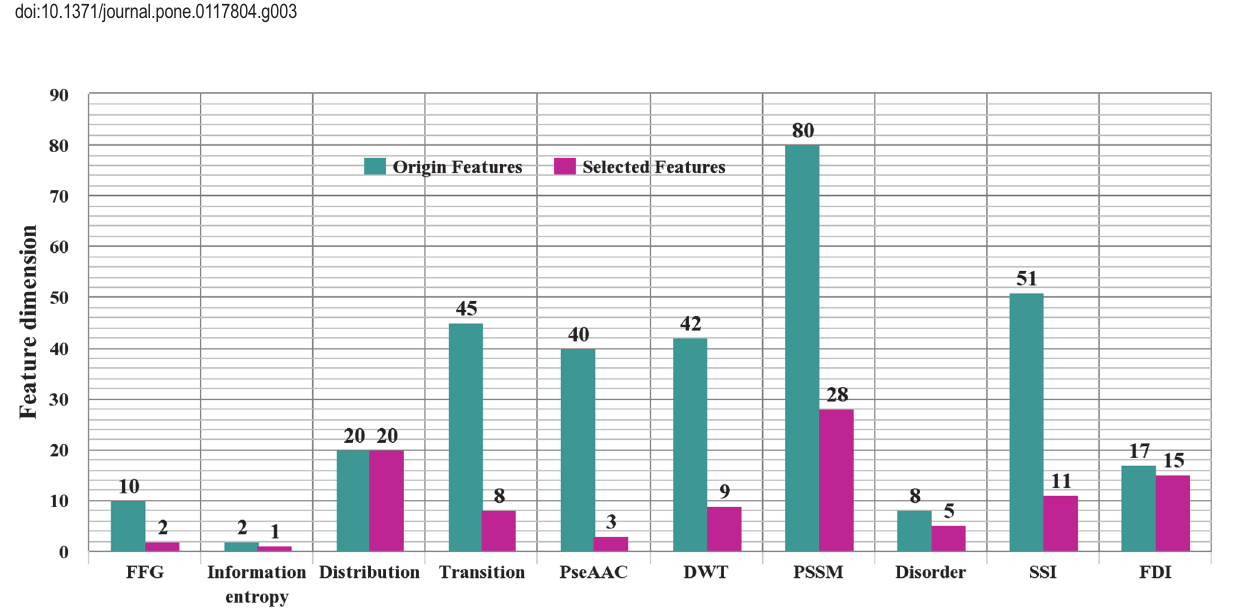
Fig 4. The feature type distributions in the original and optimal feature set. FFG: Frequencies of Functional Groups, PseAAC: Pseudo Amino Acid Composition, DWT: Discrete Wavelet Transformation, PSSM: Position Specific Scoring Matrix, SSI: Secondary Structural Information, FDI: Functional Domain